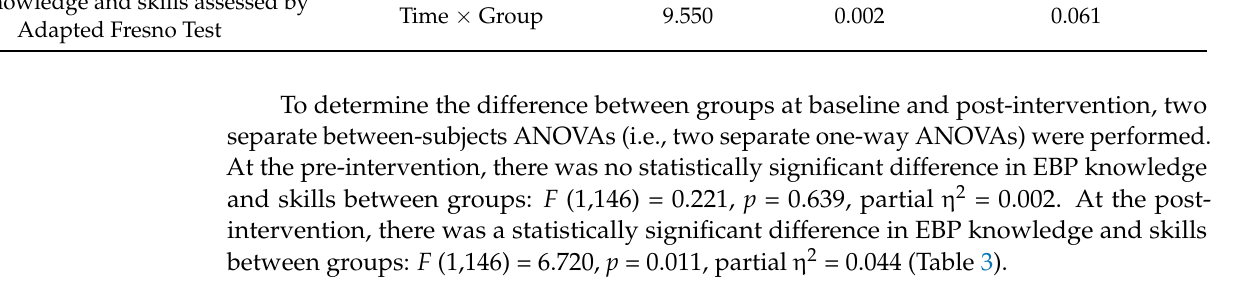
Table 2. Main effects of time and group and interaction effects on EBP knowledge and skills—ITT analysis. Outcome Measure